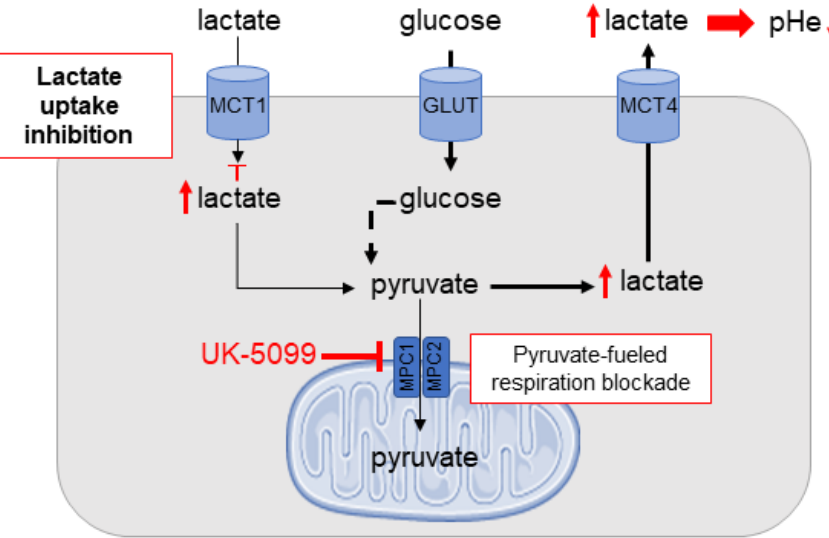
Figure 1. Model depicting the mechanism of extracellular acidification upon MPC inhibition. Because acidosis within the tumor micro-environment may have profound impact on cancer progression and treatment efficacy, this last observation prompted us to further explore the effect of MPC inhibition on the extracellular pH (pHe) in vivo. To reach this goal, we have used two non-invasive nuclear magnetic resonance methods [20]. Among magnetic resonance imaging (MRI) modalities, the chemical exchange saturation transfer (CEST) approach has emerged as a technology that provides high spatial resolution